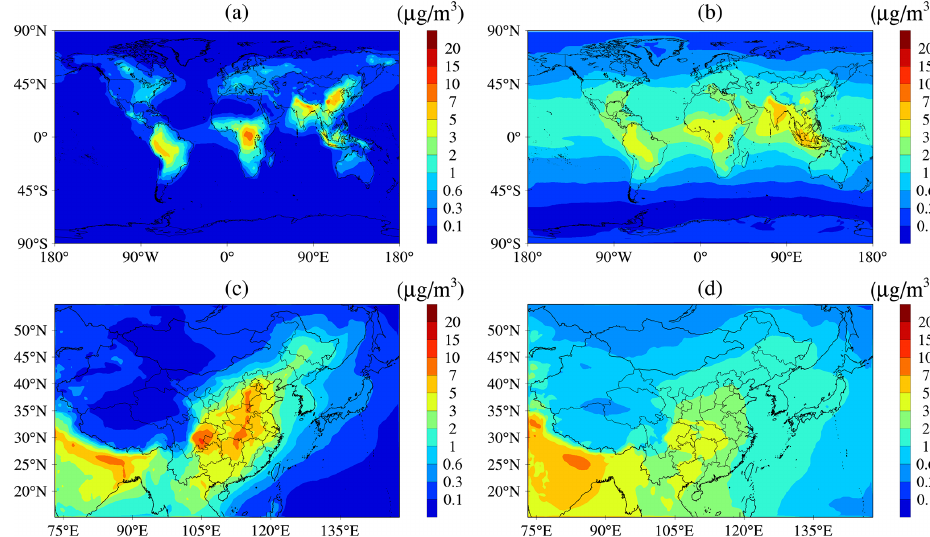
Figure 6. Surface layer horizontal spatial distributions of SV-SOA concentrations (a, c) and LV-SOA concentrations (b, d) over the first domain (a, b) and second domain (c, d) .